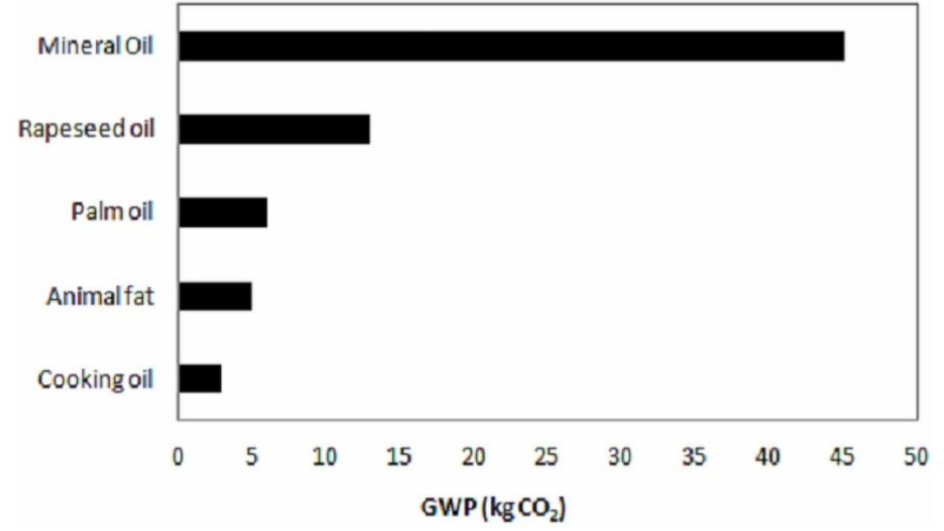
Figure 2. Global Warming Potential of Various Oils [58].